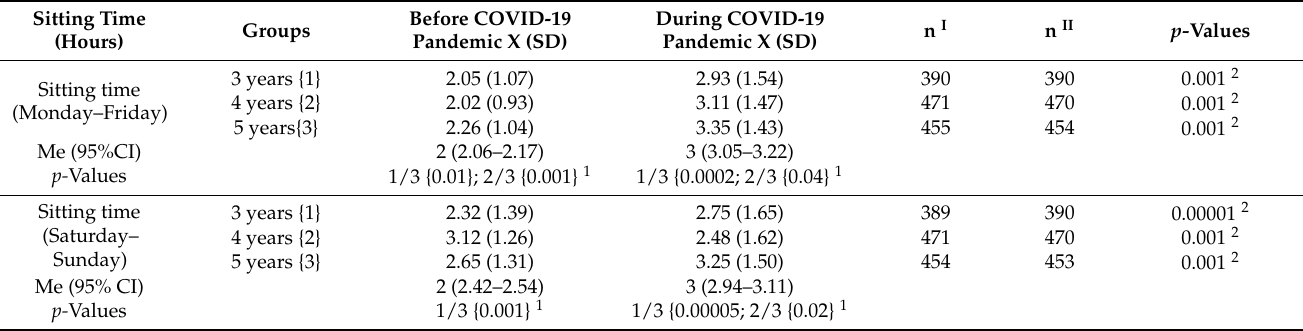
Table 2. Participants’ sitting time before and during the